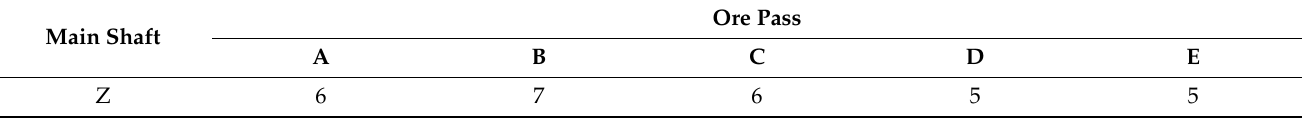
Table 9. Unloaded haulage number of times of electric locomotives (Units: 1).